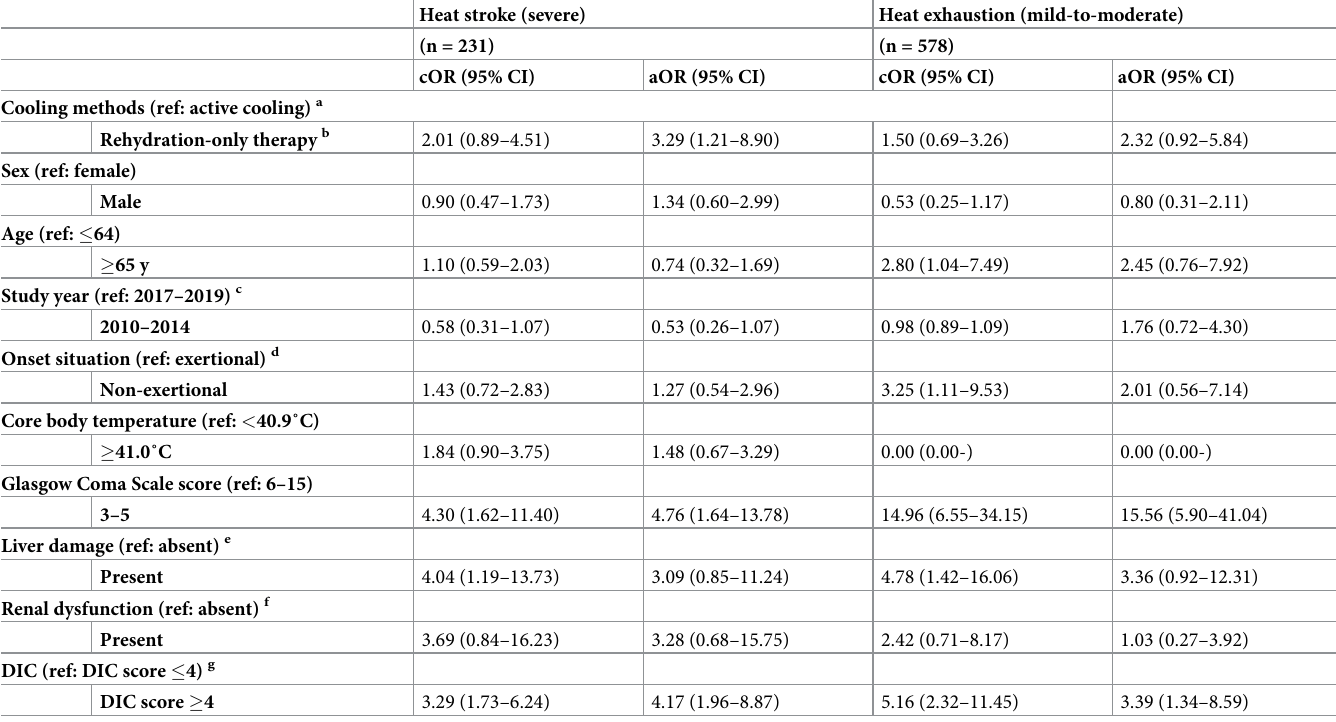
Table 2. Odds ratios of factors potentially associated with patient prognosis after heat illness